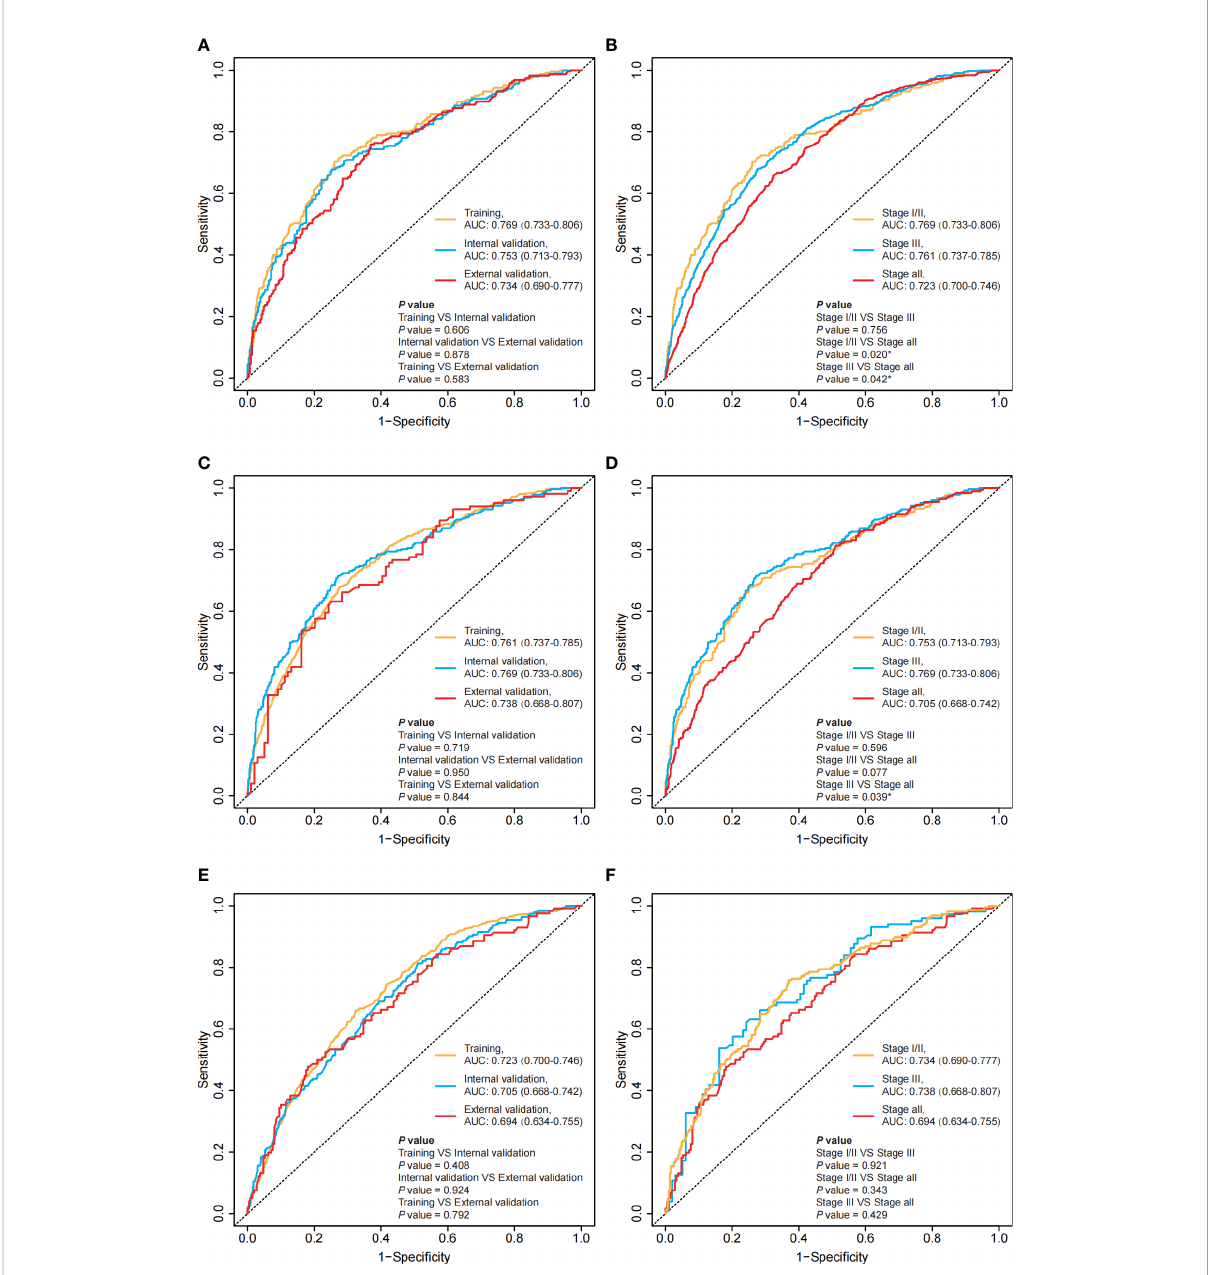
FIGURE 3 Time-ROC for the training set, internal validation set and external validation set in different groups at the 3 rd year and comparing the time-ROC between stage I/II, stage III and all-stage groups. (A) the time-ROC for the training set, the internal validation set and the external validation set in the stage I/II group at the 3 rd year; (C) the time-ROC for the training set, the internal validation set and the external validation set in the stage III group at the 3 rd year; (E) the time-ROC for the training set, the internal validation set and the external validation set in the all-stage group at the 3 rd year; (B) the time-ROC comparing the stage-speci fi c prediction models and the uni fi ed model in the training set; (D) the time-ROC comparing the stage-speci fi c prediction models and the uni fi ed model in the internal validation set; (F) the time-ROC comparing the stage- speci fi c prediction models and the uni fi ed model in the external validation set. *: P